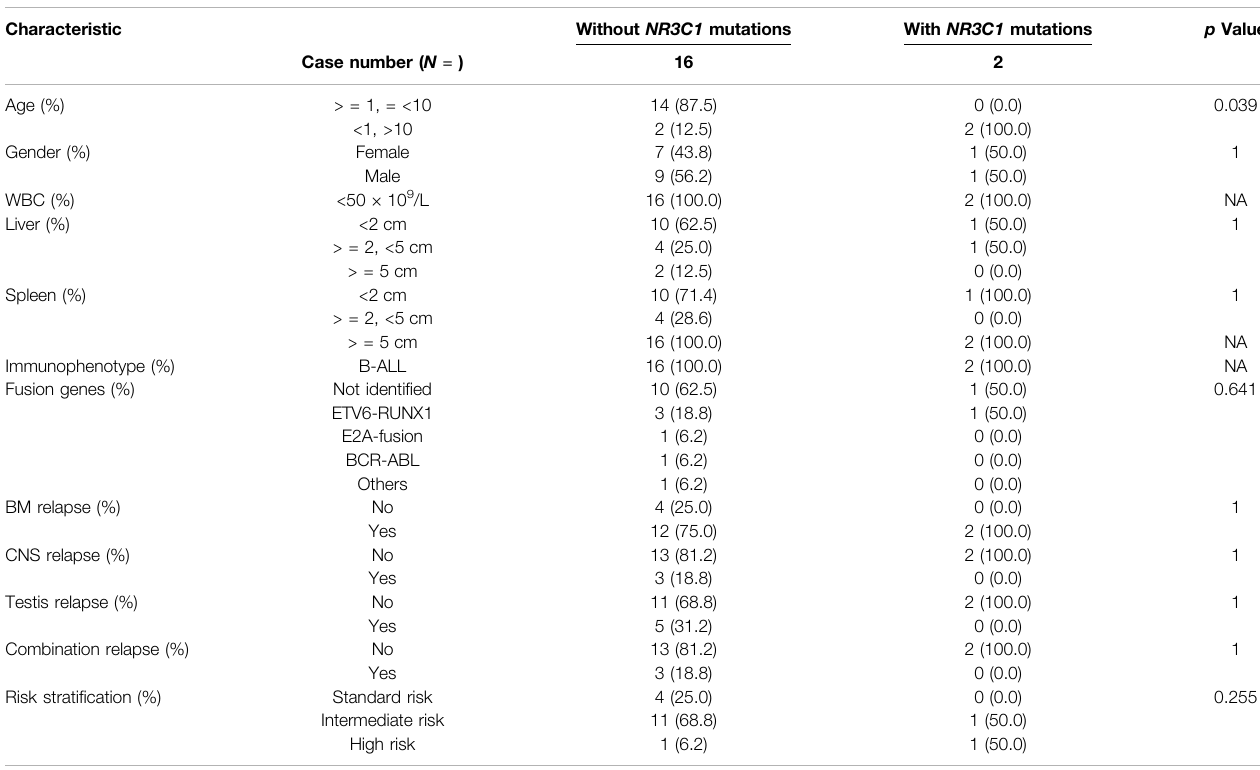
TABLE 2 | Baseline characteristics of relapsed ALL patients with or without NR3C1 mutations.